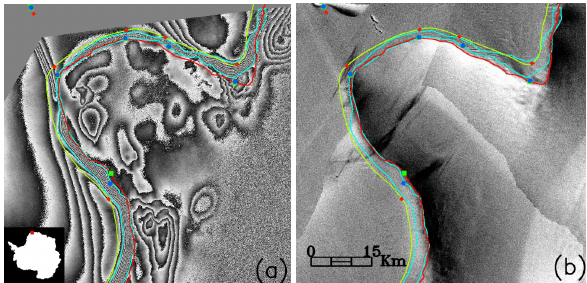
Figure 2. Section of Antarctic coast (Halvfarryggen Ridge on the Princess Martha Coast with Ekström Ice Shelf on left) 71.6 km x 69.7 km comparing mappings of different features of the grounding zone with different methods. (a) Interferometric fringe pattern produced by InSAR methods and (b) an enhance subset of the Landsat Image Mosaic of Antarctica. Cyan lines represent edges of the tidally flexed grounding zone between points F and H (see Figure 1). Symbols are key points of the grounding zone identified from repeat ‐ track GLAS elevation profiles (F, green square; I b , blue circle; H, red diamond). Red and green lines are ASAID grounded ice boundary and hydrostatic lines, respectively.